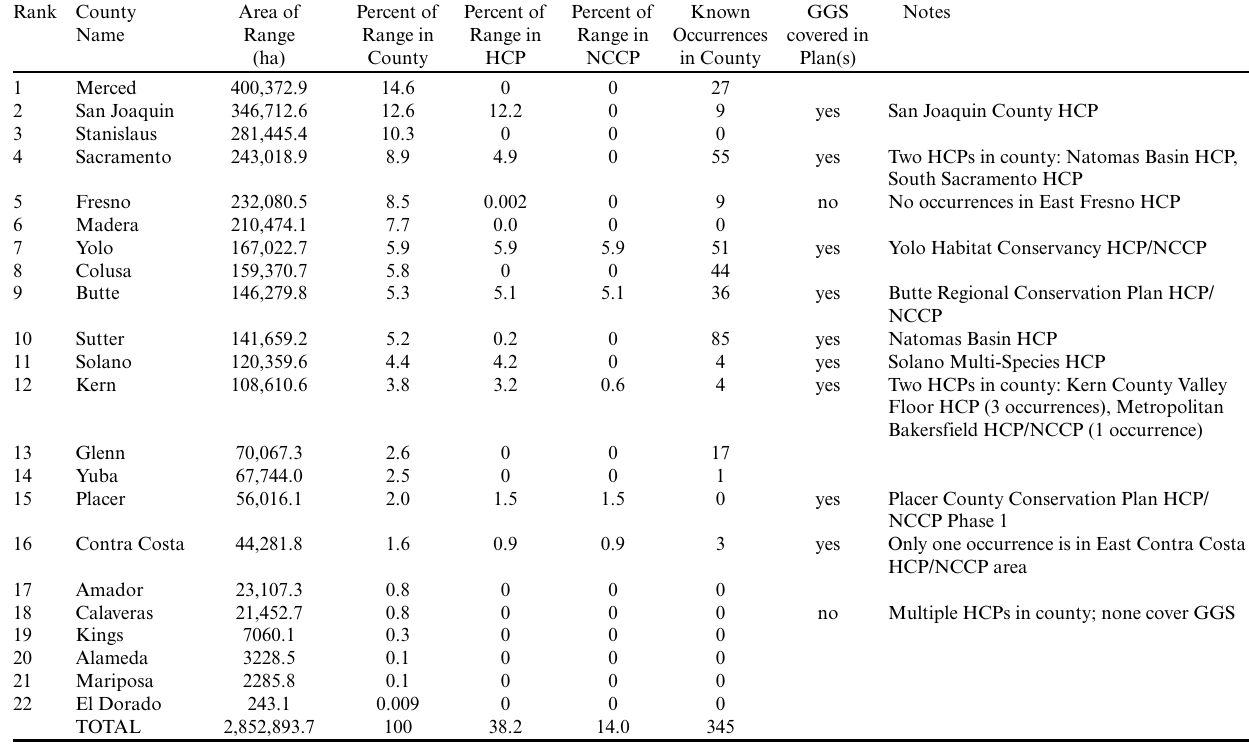
Table 1 . A summary table of the counties containing the giant garter snake’s (GGS; Thamnophis gigas ) geographic range listed in rank order from largest to smallest percent area. Also shown are the habitat conservation plans (HCPs), natural community conservation plans (NCCPs), and the frequency of known occurrences of the GGS (from the California Natural Diversity Database). Rank numbers correspond to Figure